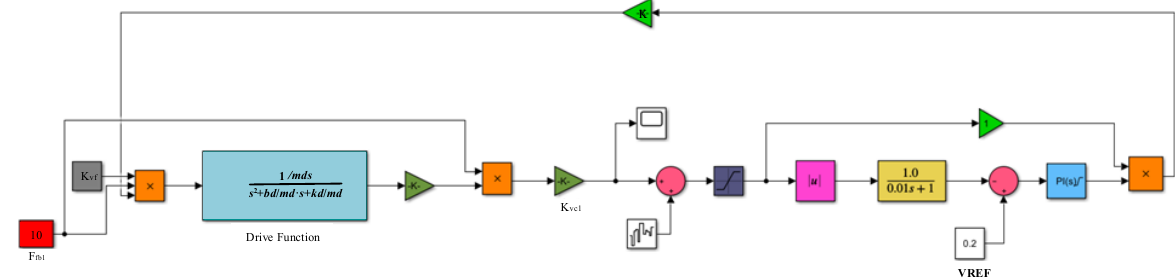
Figure 6. System-level model of gyroscope driving circuit.